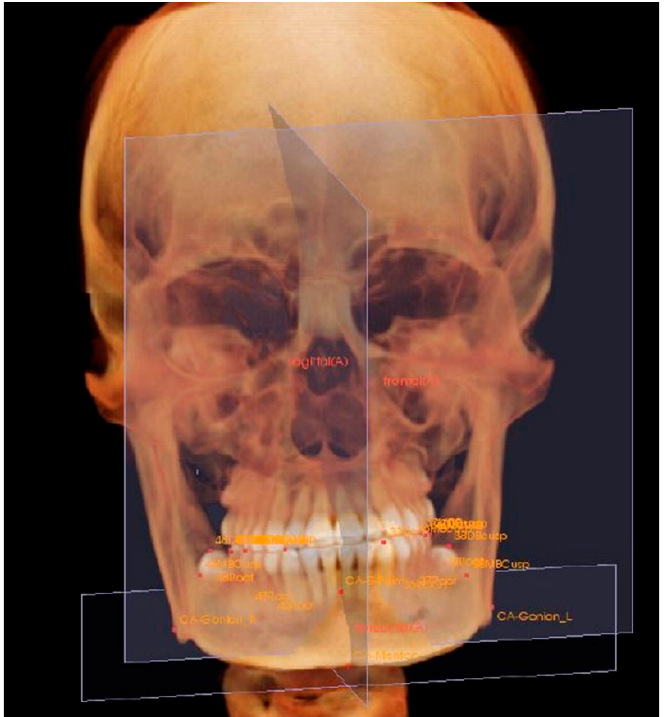
Figure 2. Reorientation of X, Y, and Z reference planes using landmarks: menton; gonion; B point; pogonion; mental foramen. The horizontal plane (X-axis) was the plane passing the menton and parallel to a plane extending through the right and left mental foramen and pogonion. The sagittal plane (Y-axis) was perpendicular to the horizontal plane at the menton and passed through the B point. The frontal plane (Z-axis) was perpendicular to both planes and passed through the